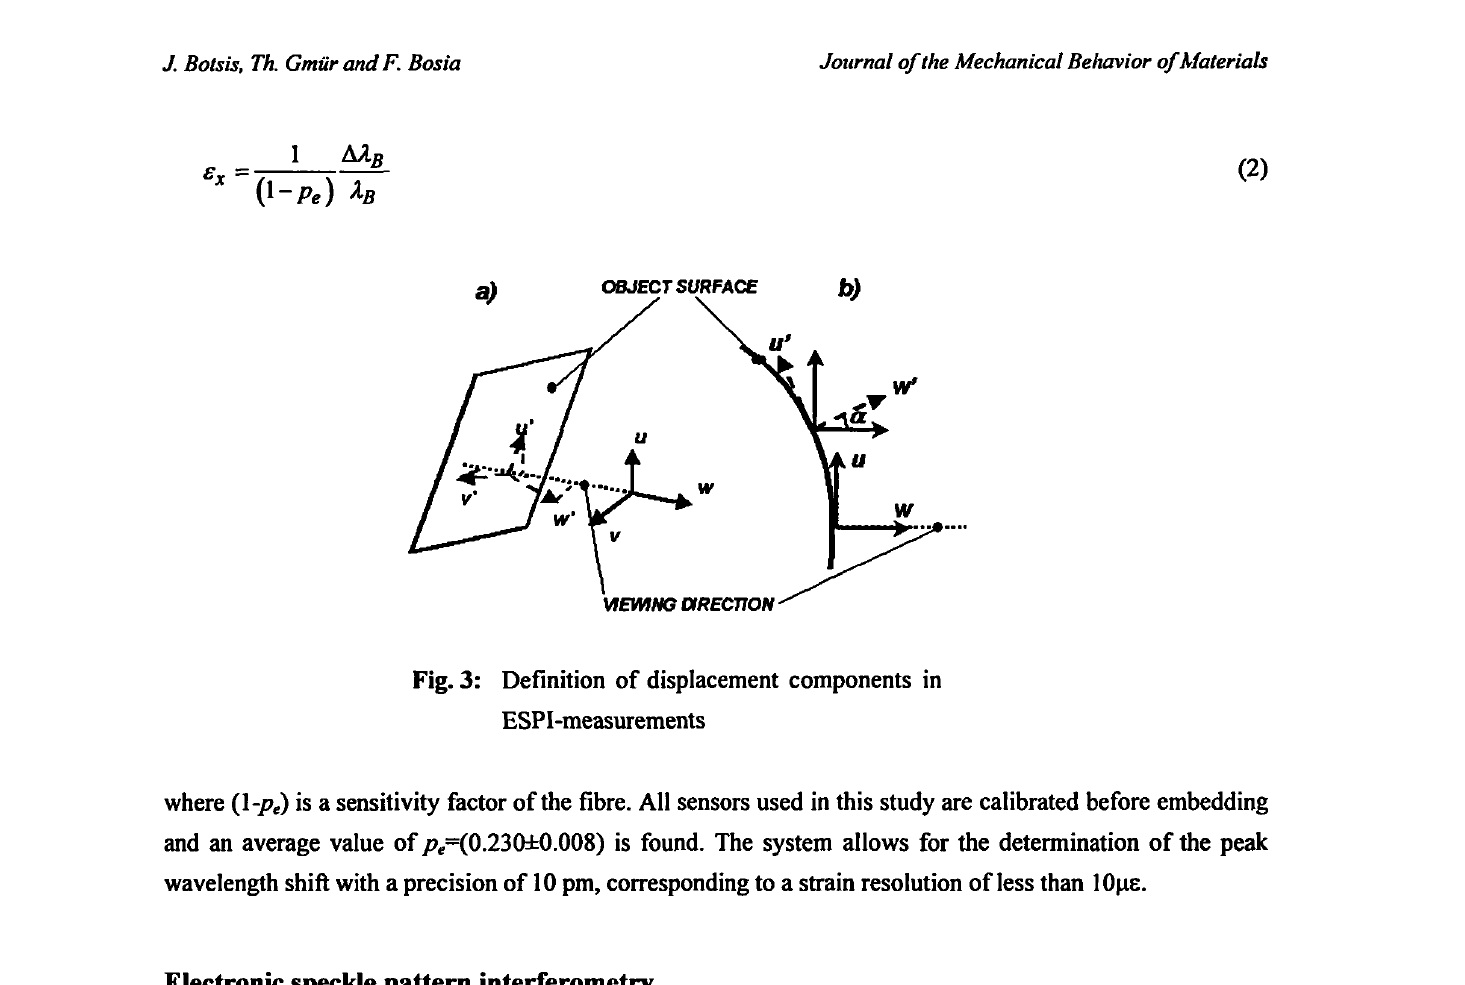
Fig. 3: Definition of displacement components